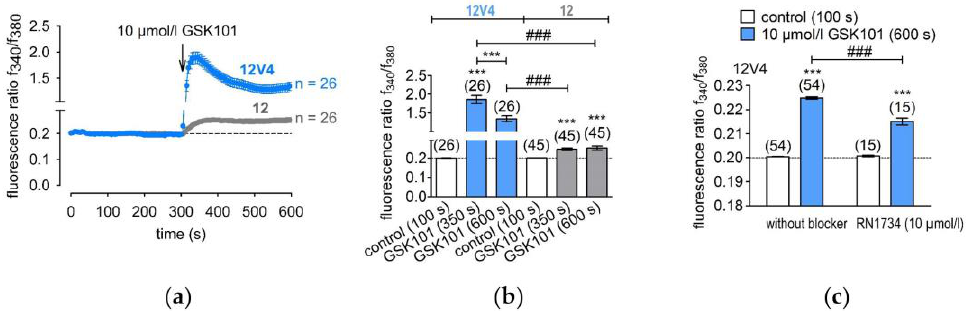
Figure 4. TRPV4 mediated calcium influx in non-transduced HCEC-12 (12) and TRPV4-overexpressing (12V4) cells. ( a ) Time course of the fluorescence ratio (f 340nm /f 380nm ) of 12V4 (±SEM; n = 26; blue trace) and HCEC-12 cells (±SEM; n = 26; grey trace). GSK101 (10 µmol/L) was applied after 4 min (arrow). ( b ) Summary of the experiments with GSK101 in 12V4 cells and HCEC-12; *** denotes a significant increase in [Ca 2+ ] i in the presence of GSK101 (t = 350 s and 600 s) ( ± SEM; n = 26; p < 0.005; paired tested) compared to control (t = 100 s); ### indicates a statistically significant difference in fluorescence ratios of the GSK101 effect in 12V4 cells and HCEC-12 ( ± SEM; n = 26; p < 0.005; non-paired tested). ( c ) Summary of the experiments with GSK101 and RN1734 in 12V4 cells; *** denotes a significant increase in [Ca 2+ ] i in the presence of GSK101 (t = 600 s) ( ± SEM; n = 54; p < 0.005; paired tested) compared to control (t = 100 s); ### indicates a statistically significant dif- ference in fluorescence ratios of the GSK101 effect in 12V4 cells with and without RN1734 ( ± SEM; n = 15–54; p < 0.005; non-paired